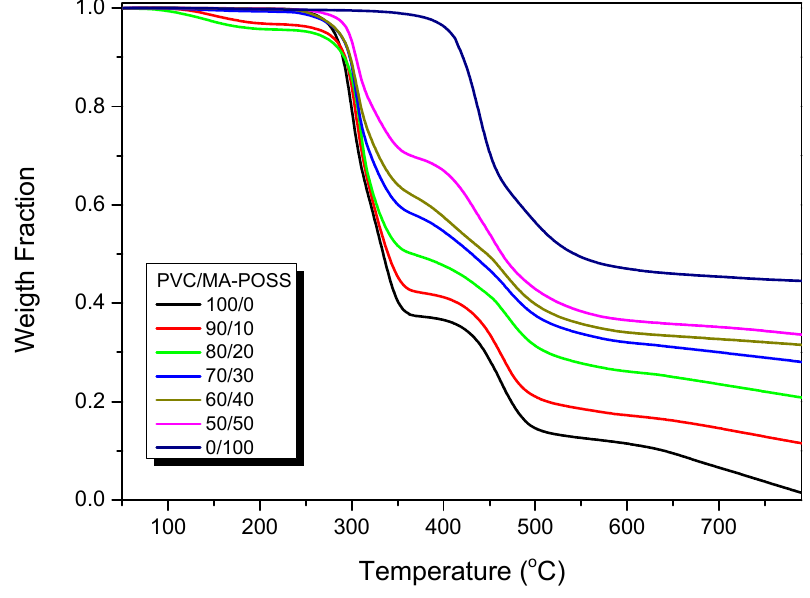
Figure 5. TGA analyses of PVC/MA-POSS blends of various compositions.